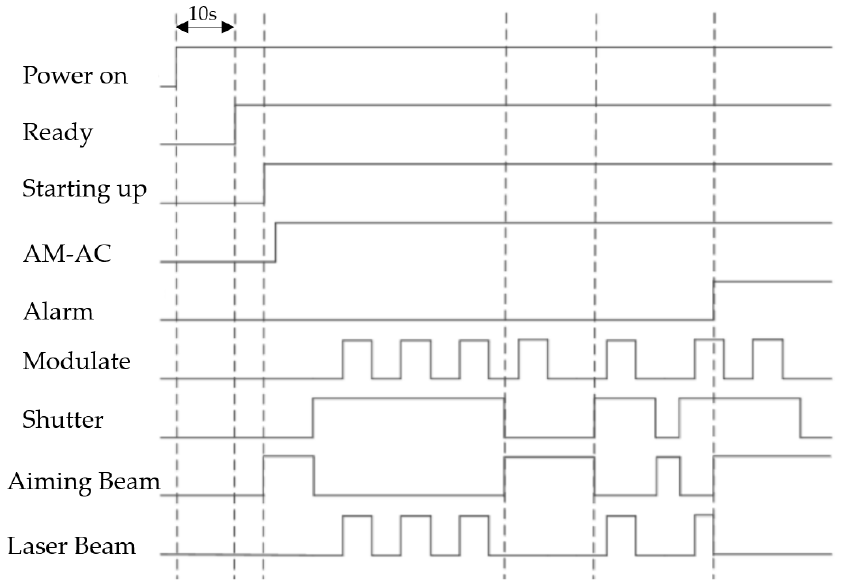
Figure 1. Phase modulation sequence diagram of the fiber laser.